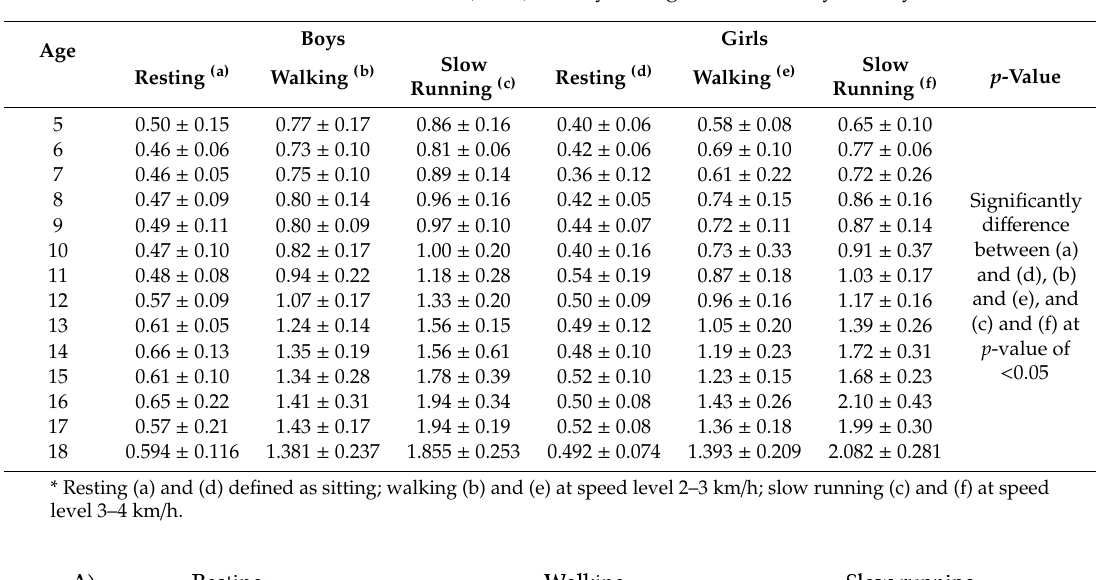
Table 3. Short-term inhalation rate (m 3 /h) for boys and girls stratified by activity levels.